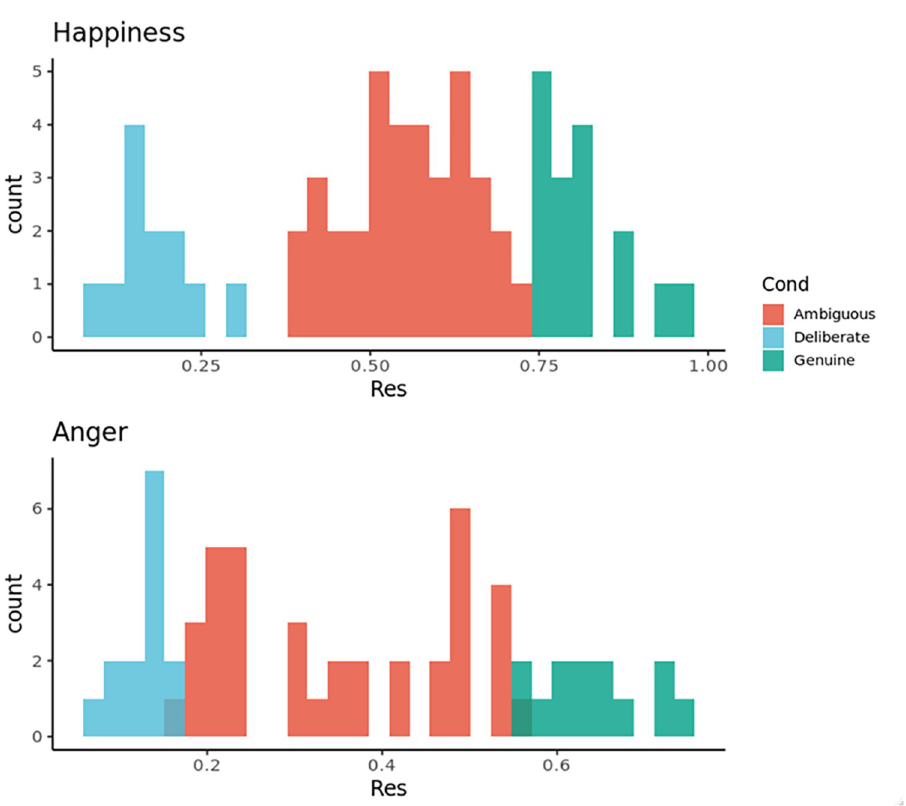
Fig 1. The histogram of Yes responses for the genuineness judgment of happiness (upper part) and anger (lower part).